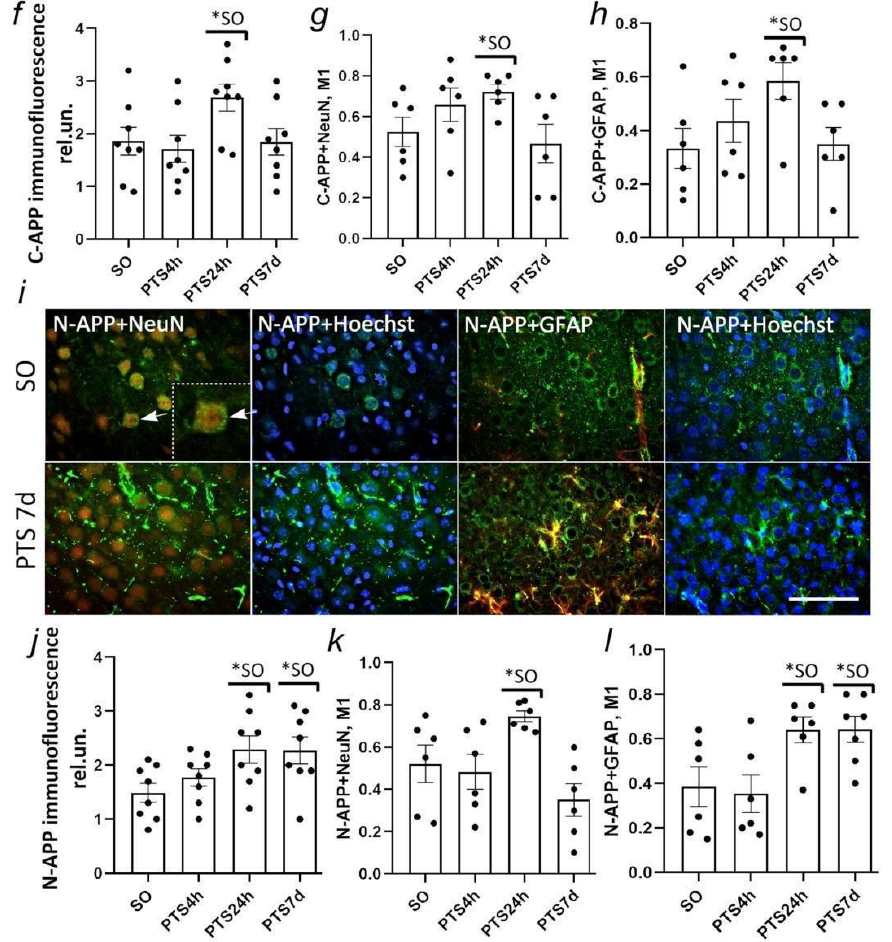
Figure 1. ( a , b ) Immunoblotting of C- and N-APP in the cytoplasmic fraction of the cortex of sham- operated animals (SO4 and SO24), at 4 (PTS 4 h) and 24 (PTS 24 h) hours after photothrombotic stroke in the cerebral cortex of rats and the contralateral cortex of the same rats (CL4 and CL24, respectively); ( c , d ) C- and N-APP level in relative units at different times after PTS; ( e , i ) Immunofluorescence of C- and N-APP (green); image overlay of C- and N-APP with NeuN (neuron marker, red), GFAP (astrocytes marker, red), and 33342 Hoechst (nuclei marker, blue). Scale bar 100 µ m. Image overlay of ADAM10 with NeuN and with Hoechst. Scale bar 100 µ m. Insert: enlarged image. Scale bar 50 µ m. Arrows show granularity in the cytoplasm. ( f , j ) C- and N-APP fluorescence in penumbra cells after PTS and the cortex of sham-operated rats. ( g , k ) Localization of C- and N-APP in penumbra neurons. ( h , l ) Localization of C- and N-APP in penumbra astrocytes. The indices of the groups of sham- operated animals at 4 h, 24 h, and 7 days after irradiation had no statistically significant differences, therefore the indices of the three groups were combined (SO). One-way ANOVA. M ± SEM. n = 6–8. * p < 0.05; ** p <